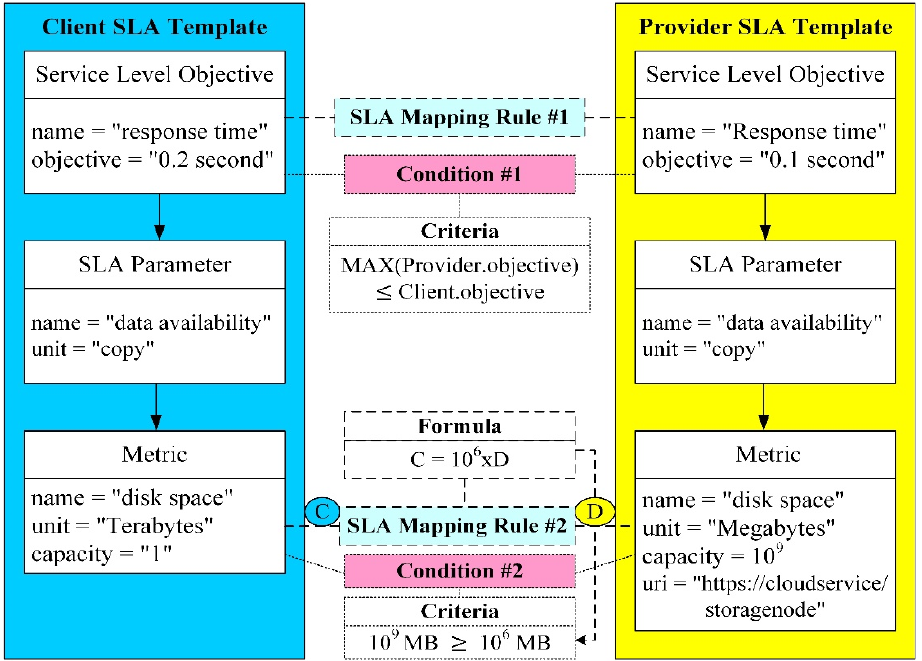
Figure 4. SLA mapping mechanism.